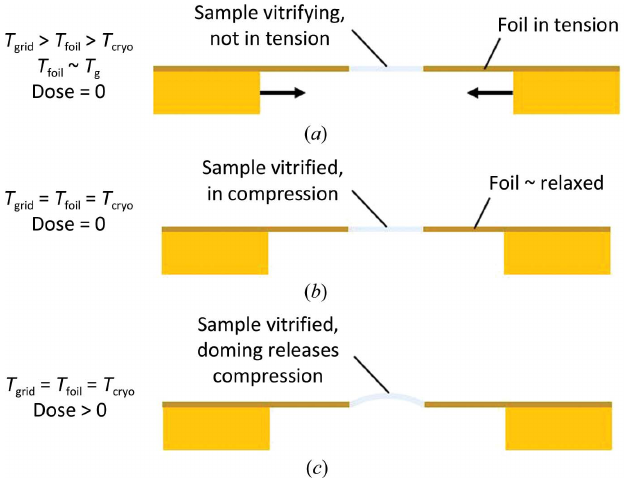
Figure 2 Schematic illustration of how compressive stress and doming may be generated during plunge-cooling of cryo-EM samples. ( a ) The sample and foil have cooled to T g and the foil is under tensile stress between the warmer grid bars. ( b ) The sample, foil and grid have reached the final temperature T cryo ; tensile stress in the foil associated with the transient temperature difference between the grid and foil has been released, and the sample is now under compression. ( c ) After receiving an electron dose D , radiation-induced creep in the presence of compressive stress has produced doming of the sample within the holes in the